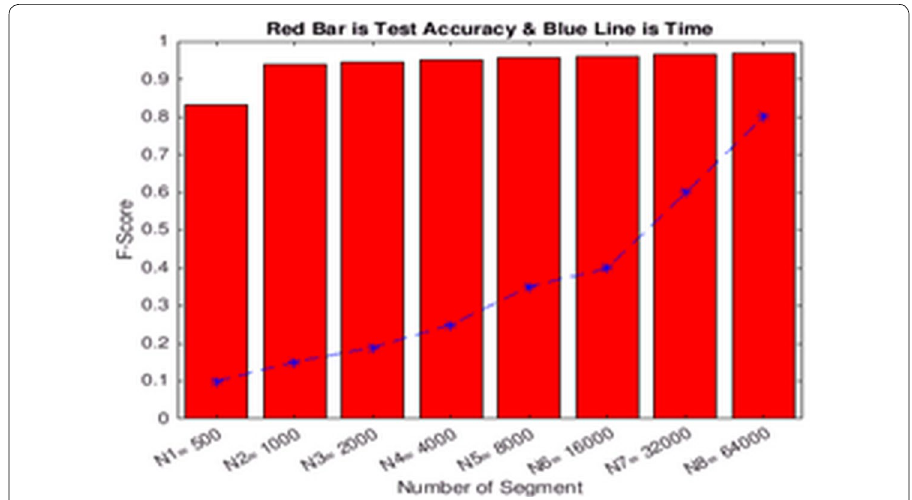
Fig. 4 Diagnosis results using different segment